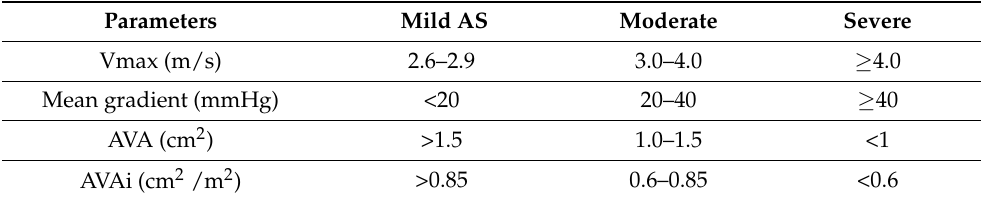
Table 1. Recommendations for grading of AS severity.